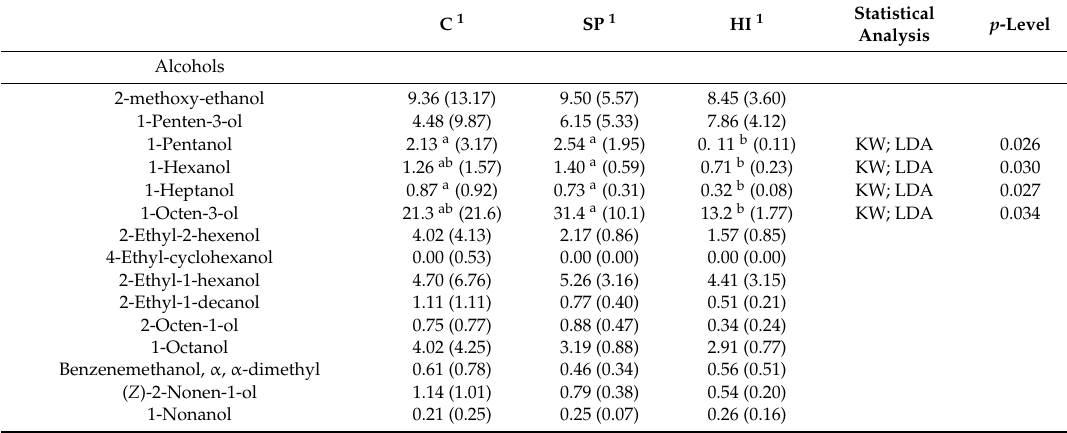
Table 1. The composition of the volatile profile of chicken breast meat fed with three di ff erent diets